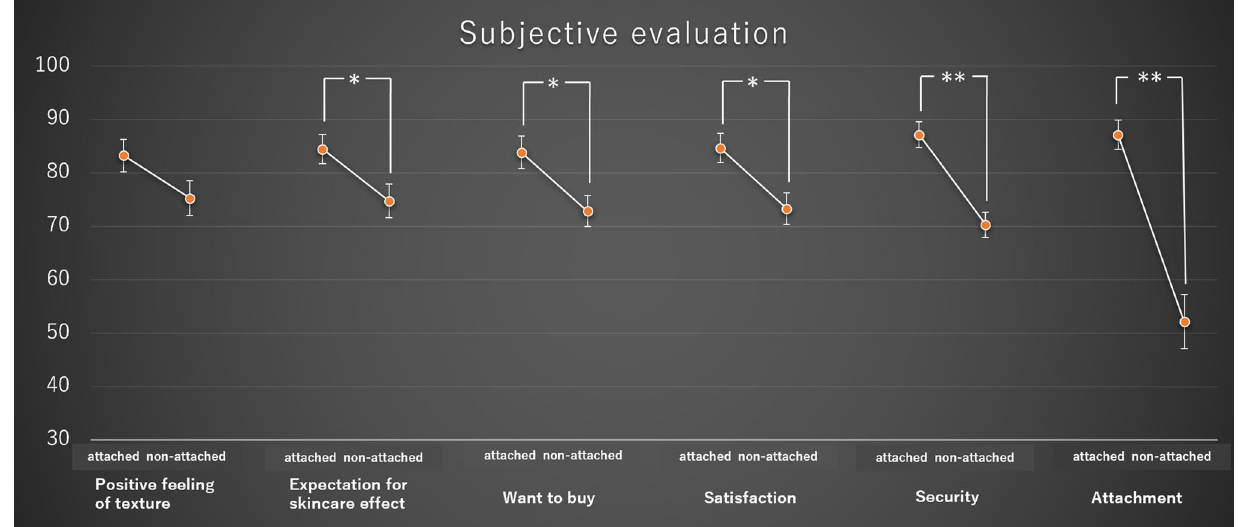
Figure 1. Comparisons of subjective evaluations between attached cosmetics versus non-attached cosmetics for each of the six items. *represents significance as assessed by a paired t-test ( p < 0.05), and **represents significance as assessed by a paired t-test ( p <